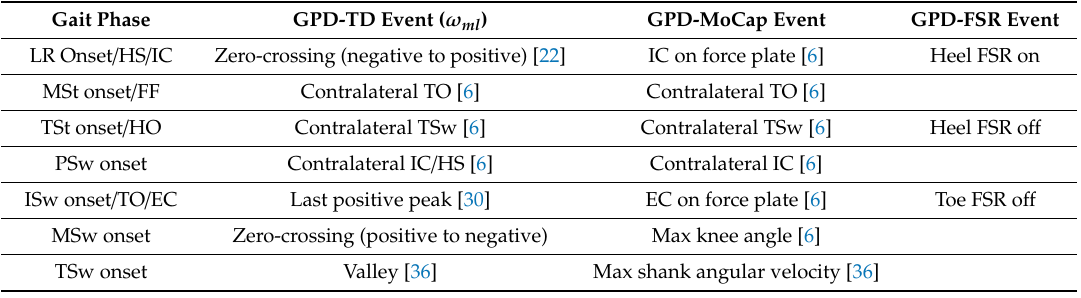
Table 2. Gait phase detection (GPD) events for the algorithm used in this paper (GPD-TD), motion-capture-based GPD (GPD-MoCap) and force-sensitive-resistor based GPD